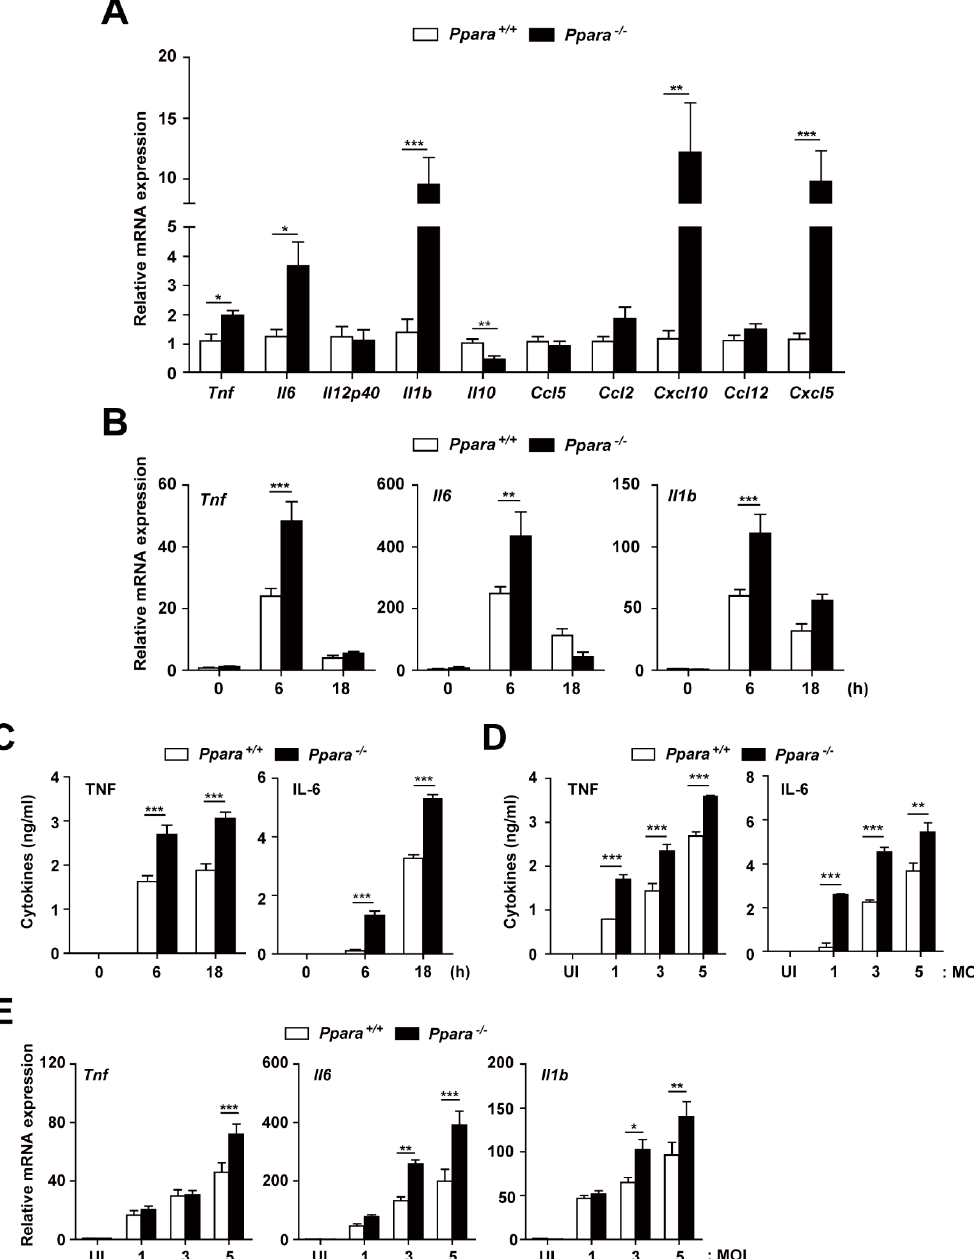
Figure 2. PPAR α protects against excessive inflammation in Mabc-infected mice and macrophages. ( A ) Proinflammatory cytokine and chemokine mRNA levels in lung tissue were determined by qRT-PCR, as in Figure 1A. ( B , C ) Ppara +/+ and Ppara -/- BMDMs were infected with Mabc (MOI of 5) for the indicated times, and the levels of proinflammatory cytokines were measured by qRT-PCR (B) or ELISA (C). ( D , E ) Ppara +/+ and Ppara -/- BMDMs were infected with Mabc (MOI of 1, 3, or 5), and the levels of proinflammatory cytokines were determined by qRT-PCR at 6 h (E) or ELISA at 18 h (D). Data are means ± SD of three independent experiments. * p < 0.05, ** p < 0.01, and *** p < 0.001. UI, uninfected.